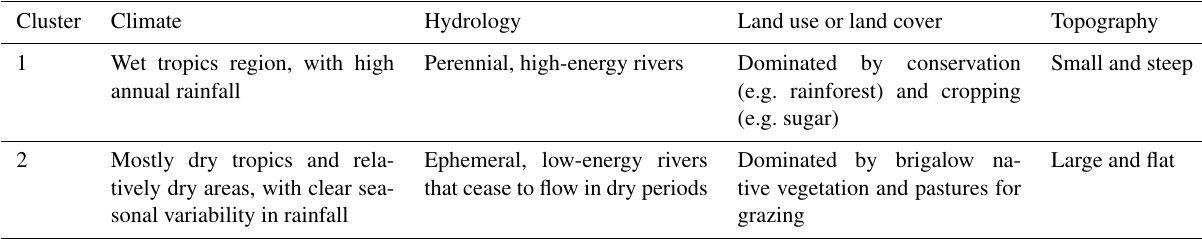
Table 1. Summary of differences in landscape characteristics between the two clusters of sites (Liu et al., 2018). Cluster Climate Hydrology